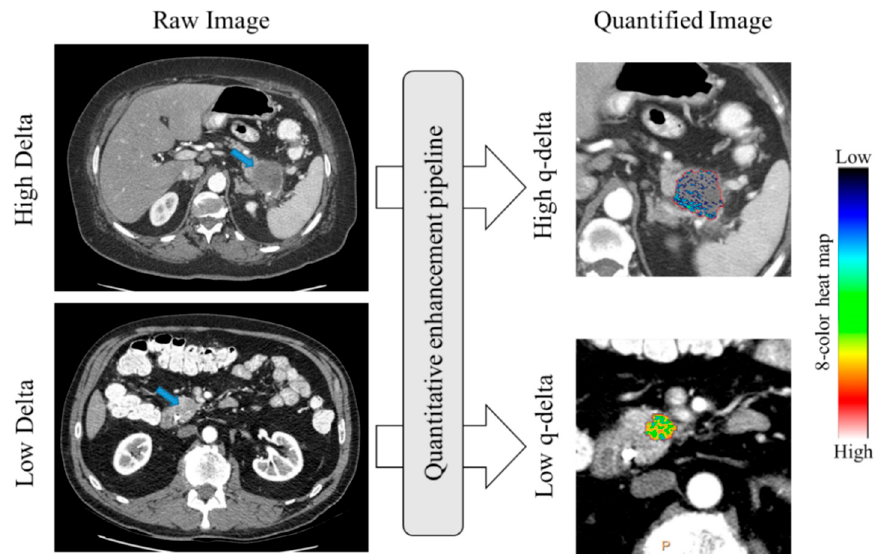
Figure 6. Quantification (q-delta) of pancreatic ductal adenocarcinoma (PDAC) biophysical subtypes. The heterogeneity within PDAC can be visualized using quantitative color